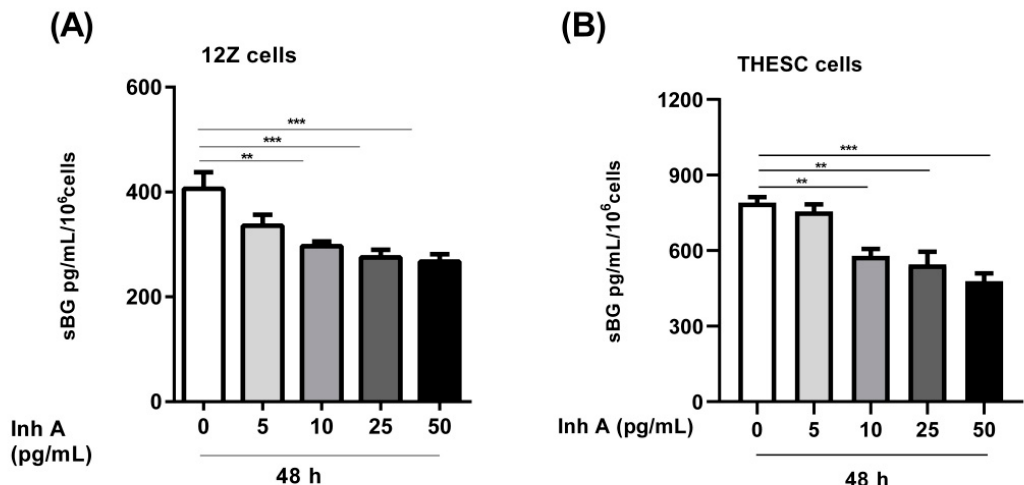
Figure 2. Concentration-dependent effects of inhibin A on BG shedding in epithelial and stromal cells. Epithelial 12Z ( A ) and stromal THESC cells ( B ) were stimulated with increasing concentrations of inhibin A (5–50 ng/mL) for 48 h and supernatants were analyzed by sBG ELISAs. Inhibin A treatment significantly reduced BG shedding in 12Z and THESC cells in a concentration-dependent manner. Untreated cells were used as controls. Each bar represents the mean ± SEM of 3 independent experiments performed in duplicate. Dunnett’s test was used for statistical analysis; ** p < 0.01; *** p < 0.001; sBG, soluble betaglycan; Inh A, inhibin A.